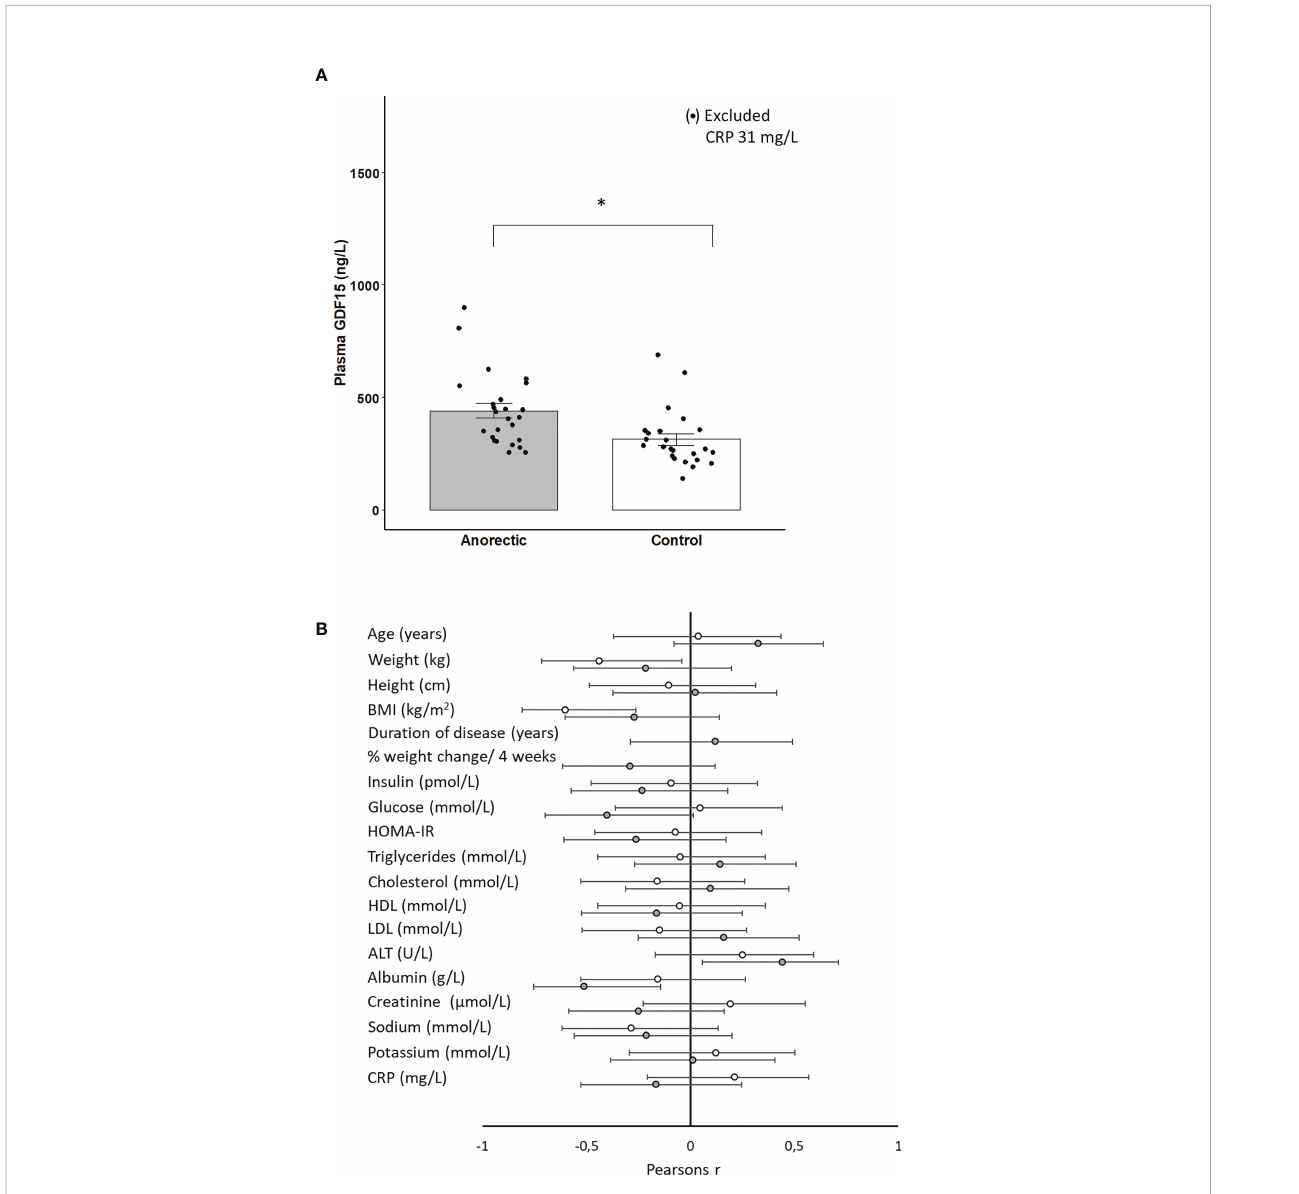
FIGURE 6 (A) Plasma GDF15 in patients with anorexia (n=25) and matched controls (n=25). In the control group, one measurement was excluded from the mean as the subject had elevated CRP. * Signi fi cant difference between groups P < 0.05. (B) Plasma GDF15 was correlated to the basal characteristics of the anorectic patients (n=25) (gray circles) and controls (n=24) (open circles). BMI: Body Mass Index, HOMA-IR: Homeostatic Model Assessment for Insulin Resistance, ALT: alanine aminotransferase, CRP: C-reactive protein. The fi gure depicts Pearsons r with 95% con fi dence